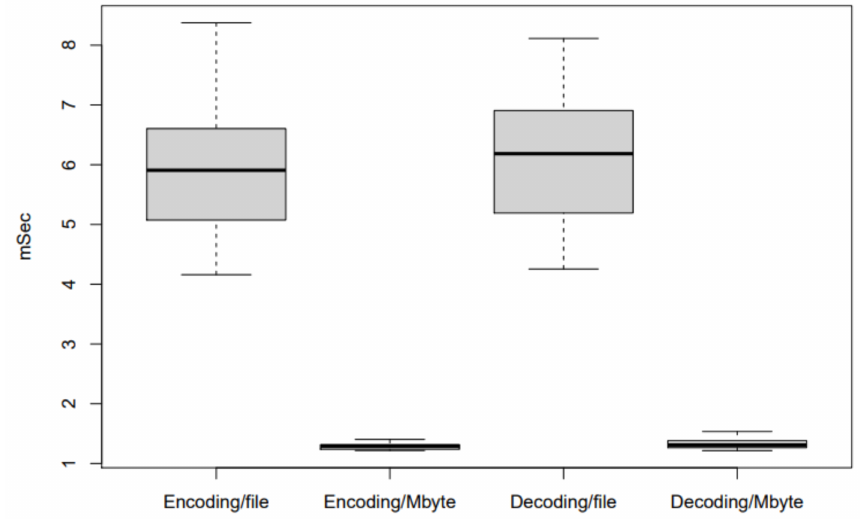
Figure 9. Boxplot without outlier (R Studio